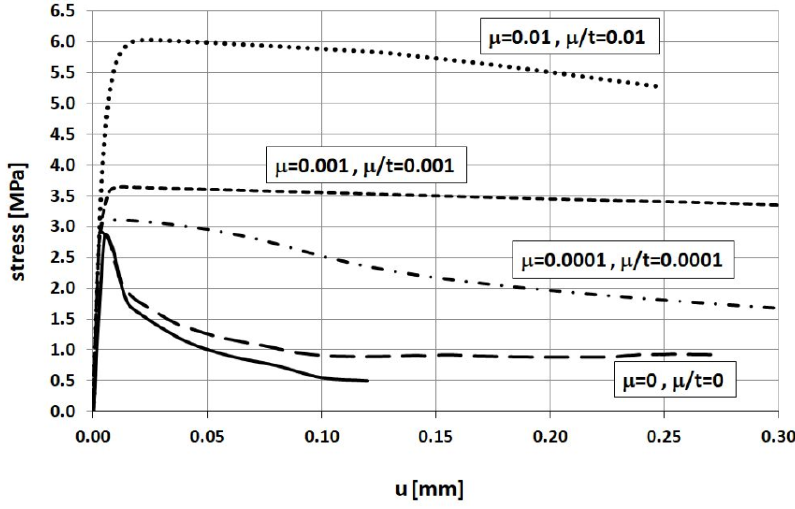
Figure 9. Displacement vs. stress relationship obtained for different relaxation time values.